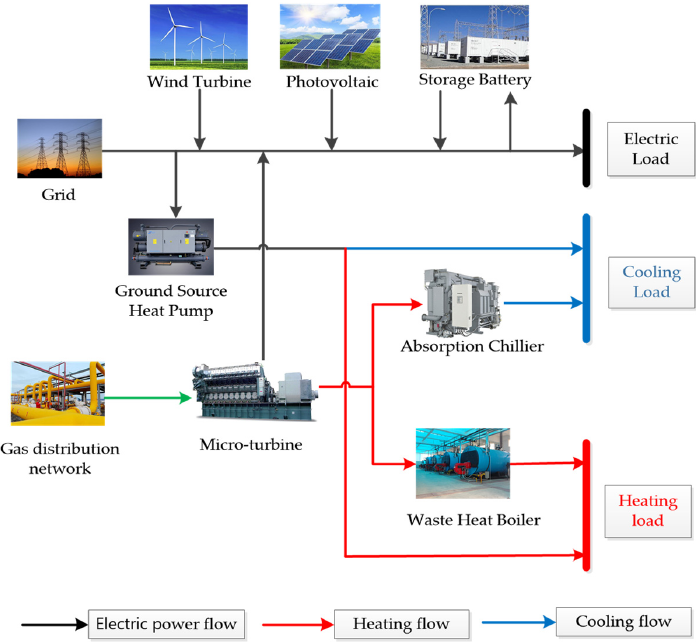
Figure 1. CCHP system structure diagram.